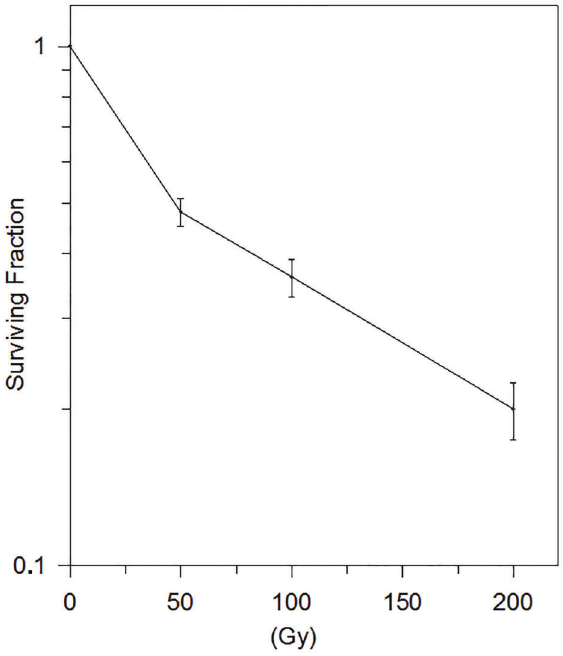
Figure 1. Surviving fractions as a function of g -ray absorbed dose (Grays: Gy). Error bars indicate 95% binomial con fi dence